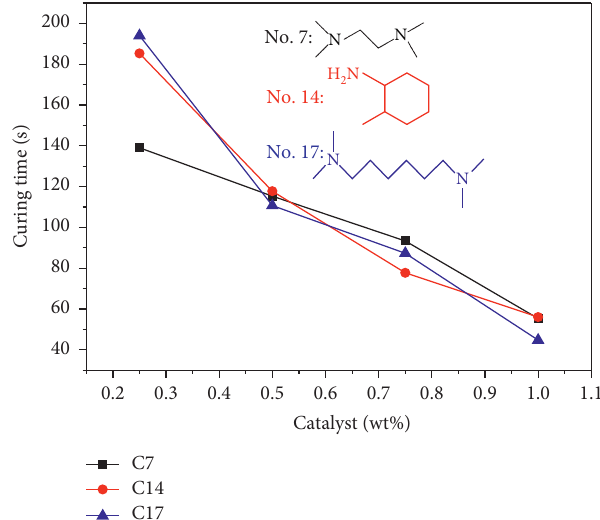
Figure 2: Curing time of samples catalyzed by different types and additive number of